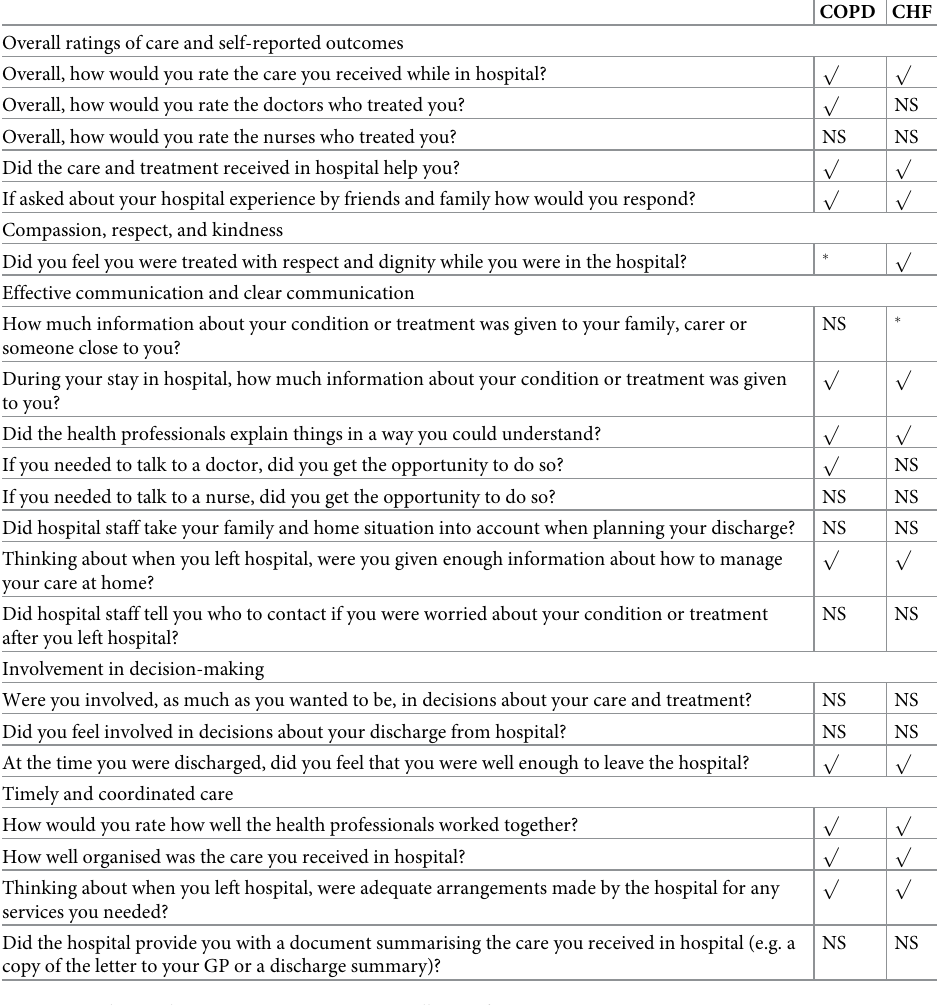
Table 1. Patient reported experiences and outcomes assessed for association with readmission to a public or pri- vate hospital within 90-days, by clinical condition, 2018–2020. Overall ratings of care and self-reported